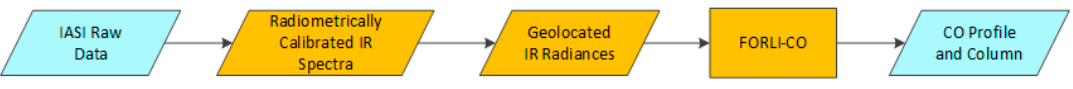
Figure 11 . QA4ECV carbon monoxide (CO) product top-level traceability chain. Figure 11. QA4ECV carbon monoxide (CO) product top-level traceability